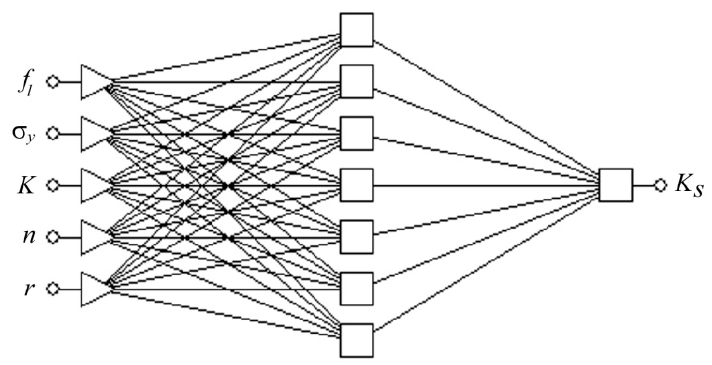
Figure 6. The architecture of the MLP 5:5-7-1:1 network.